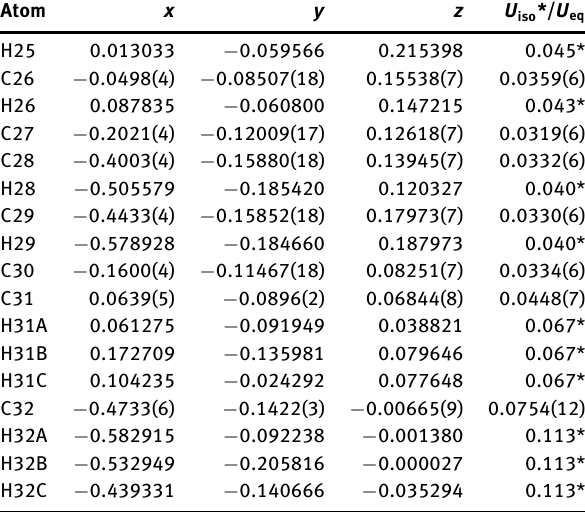
Table 2: Fractional atomic coordinates and isotropic or equivalent isotropic displacement parameters (Å 2